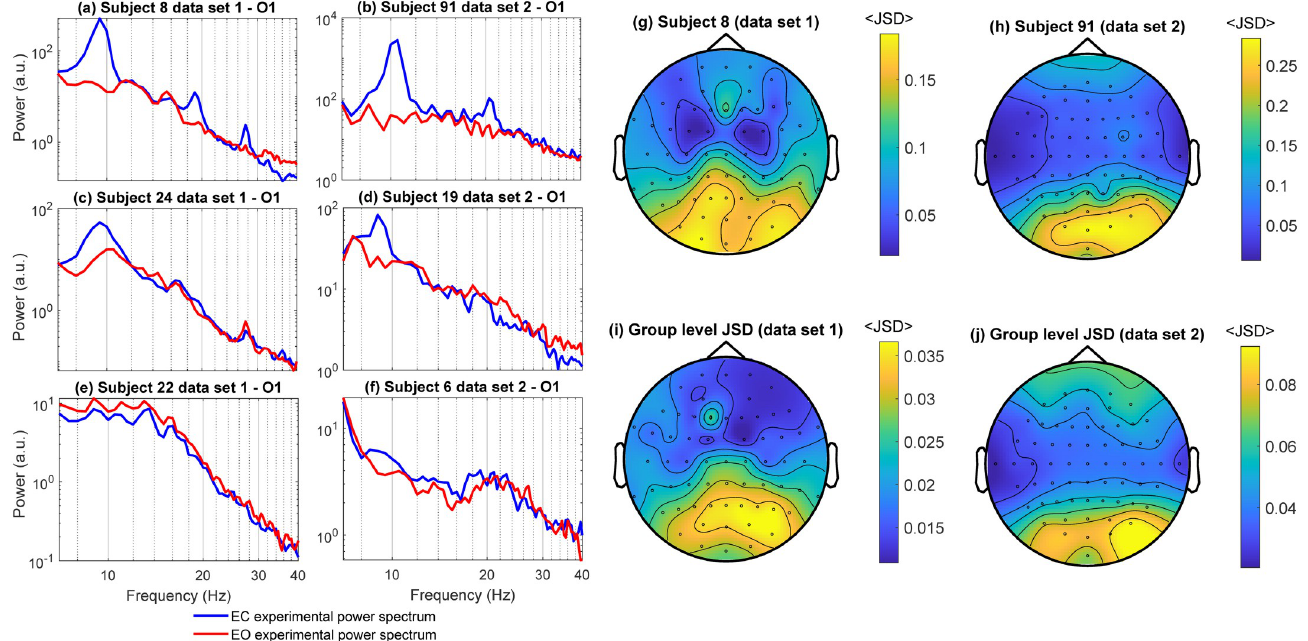
Fig 6. Spectral and topographic properties of alpha blocking in healthy participants. (a-f) Examples of spectral variation between EC and EO resting states (O1 electrode) with three subjects shown for each data set. Plots are ordered top to bottom with decreasing alpha blocking (JSD). The exemplar cases demonstrate the contrast between strong and weak alpha blockers. (g-j) Topographic maps showing the occipital dominance of alpha blocking for a typical individual (g-h) and at the group level (i-j) across data set 1 and 2. Group level average is computed across subjects on an electrode-wise basis. Note, in order to highlight the consistent pattern of occipital dominance topographic maps are all displayed using different